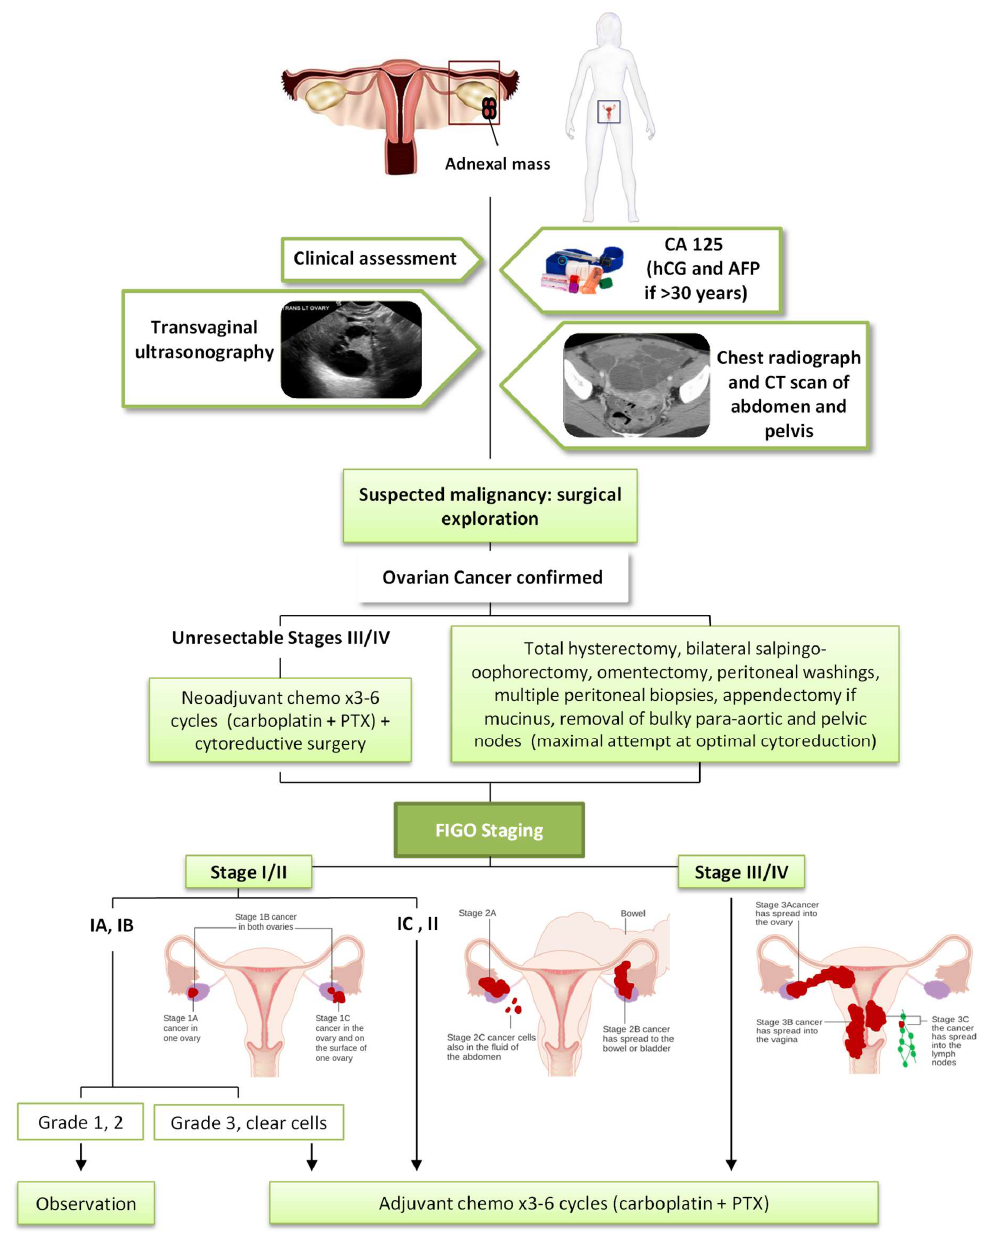
Figure 1. Algorithm for management of ovarian cancer. Figo Staging ovarian images modified from Cancer Research UK/Wikimedia Commons. Cancer Research UK/Wikimedia